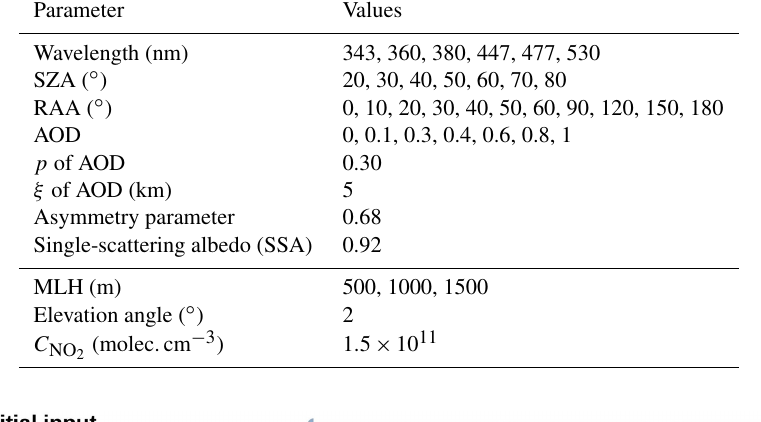
Table 2. RTM inputs for the simulations of L NO